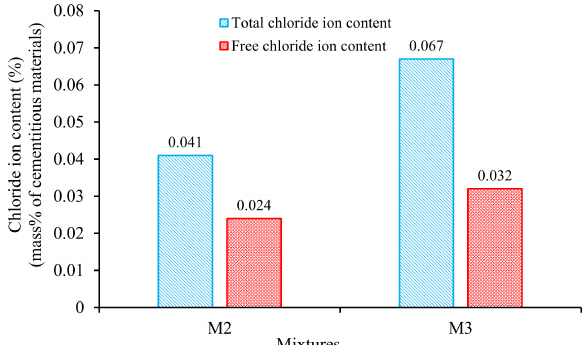
Fig. 10. Total and free chloride ion content in concrete